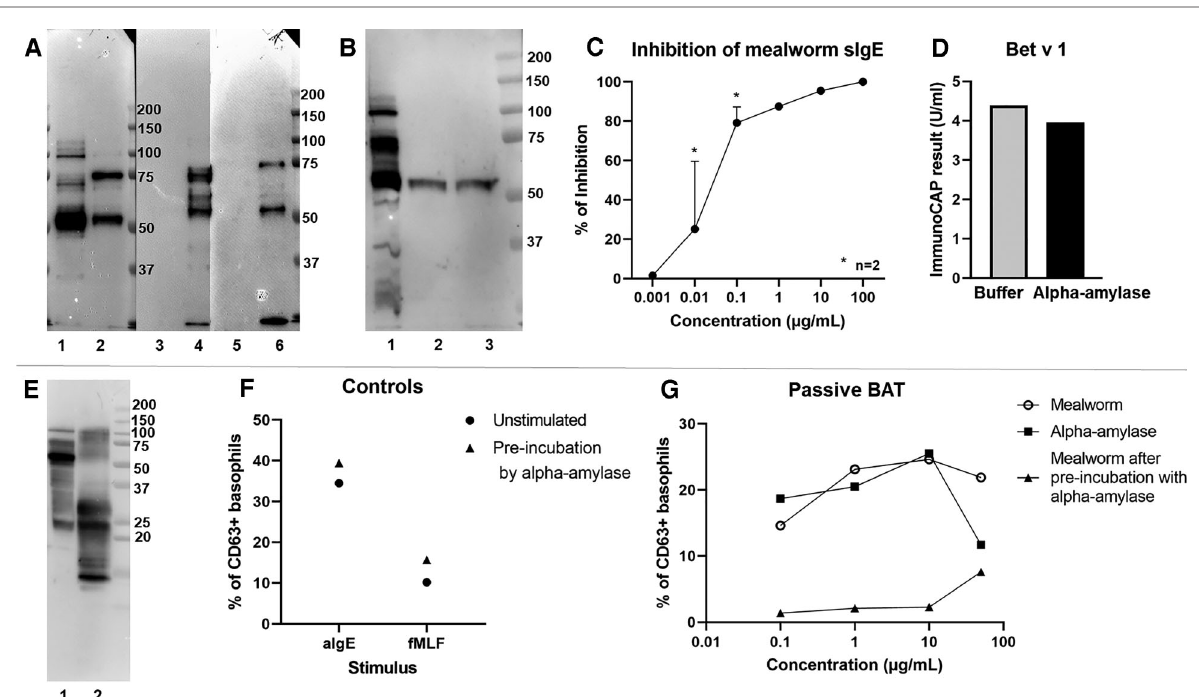
FIGURE 2 Experimental evidence demonstrating alpha-amylase to be the culprit allergen. ( A ) Immunoblot with serum of the patient and detection for IgE binding. Blotted proteins, 5 µg loaded of each: 1. mealworm; 2. beetle; 3. faeces; 4. larvae; 5. shedded skin; 6. dried mealworm ( B ) Immunoblot with serum of the patient and detection of IgE. Blotted proteins, 5 µg loaded of each: 1. mealworm; 2. pooled ion-exchange fractions E2-E3; 3. pooled ion-exchange fractions E4-E5. ( C ) Measurement of mealworm speci fi c IgE in an ImmunoCAP with pre-incubation of patient serum with alpha-amylase. Y-axis: % of inhibition, x-axis: concentration of alpha-amylase used for pre-incubation; [for 0.01 and 0.1 µ g/ml results from 2 separate experiments are shown as mean+SEM] . ( D ) Inhibition of Bet v 1 reactivity as unrelated sIgE by pre-incubation of patient serum with alpha-amylase. ( E ) Immunoblot with serum of the patient and detection of IgE. Blotted proteins, 5 µg loaded of each: 1. mealworm; 2. house dust mite (Greer). ( F ) Passive BAT results with control stimuli in baseline sensitization conditions (circles) or after pre-incubation of serum with alpha-amylase 10 µg/ml (triangles), aIgE: anti-IgE antibody, fMLF: N-formyl-methionine-leucyl-phenylalanine, % CD63+basophils normalized to the negative control (basophil stimulation buffer). ( G ) Passive BAT results after stimulation with mealworm extract (open circles), alpha-amylase (squares) or mealworm extract with pre-incubation of patient serum with alpha-amylase 10 µg/mL (triangles). Y-axis: basophil degranulation represented as % of CD63+basophils normalized to the negative control (basophil stimulation buffer), x-axis: concentration of